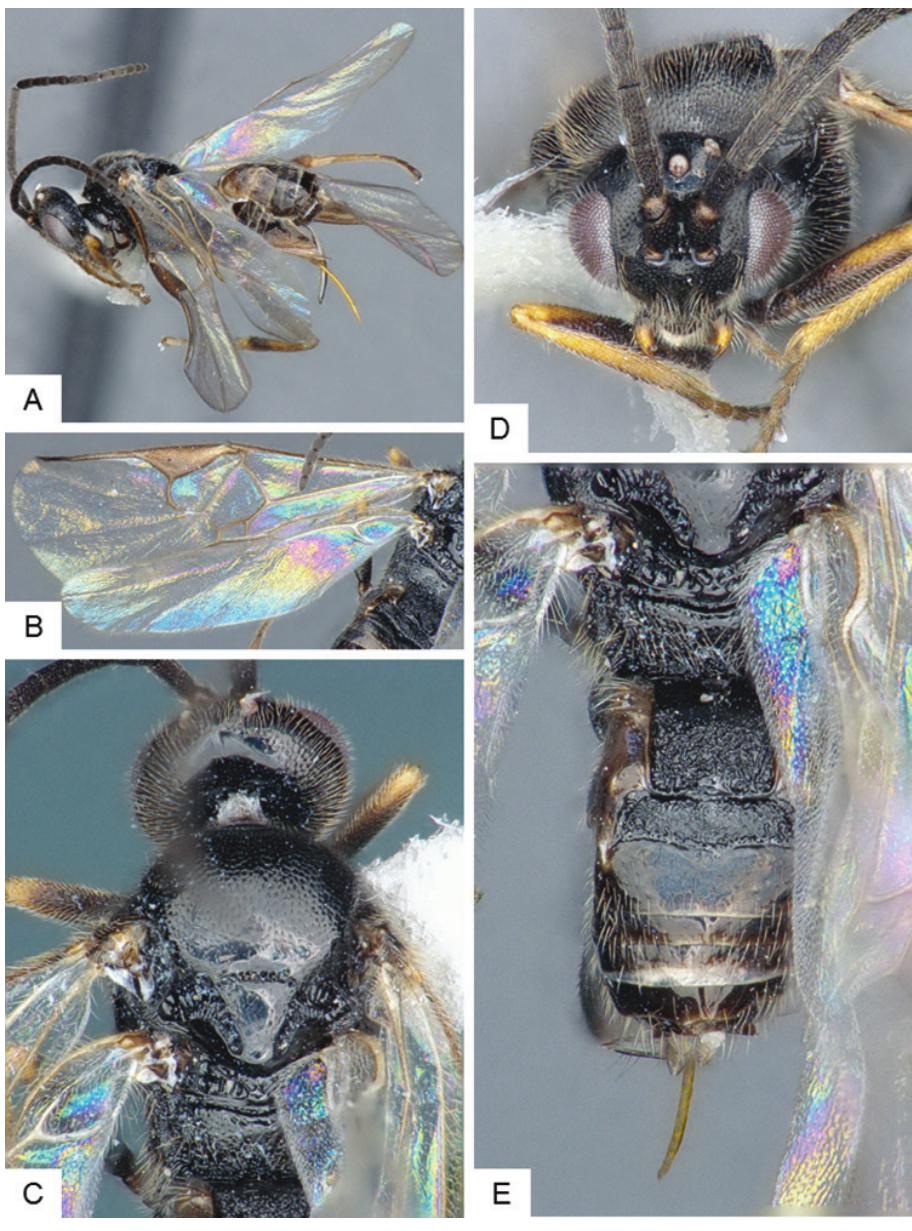
Figure 9. Dolichogenidea sp. 1. A Habitus, lateral B Fore wing and hind wing C Head and mesosoma, dorsal D Head, frontal-dorsal E Metasoma,